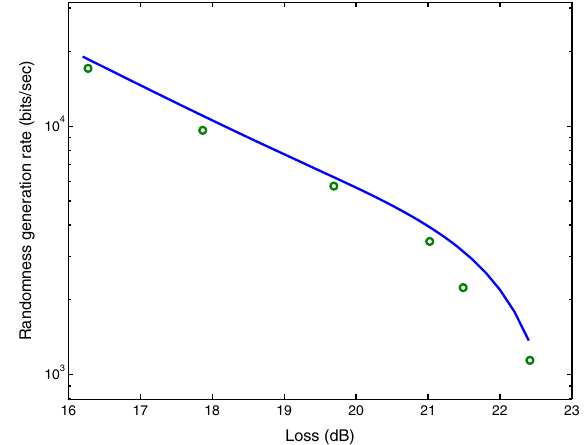
FIG. 6. Relation between the phase error rate and the loss. The big error bars are caused by a very conservative estimation of statistical fluctuations and also partially by the fluctuation of experimental parameters for different losses. order to make the photons indistinguishable. For demon- stration purposes, a biased beam splitter (BS1) with a ratio of 1 ∶ 49 is used to passively choose the X or Z basis. Finally, Alice records when the photon detector (PD) clicks. The detector is time-division-multiplexed by adding four time delays, TD1 – TD4 (60 ns each), in the optical paths so that it bases and each bit value. The gate width and the dead time of the detector are 10 and 50 ns, respectively.